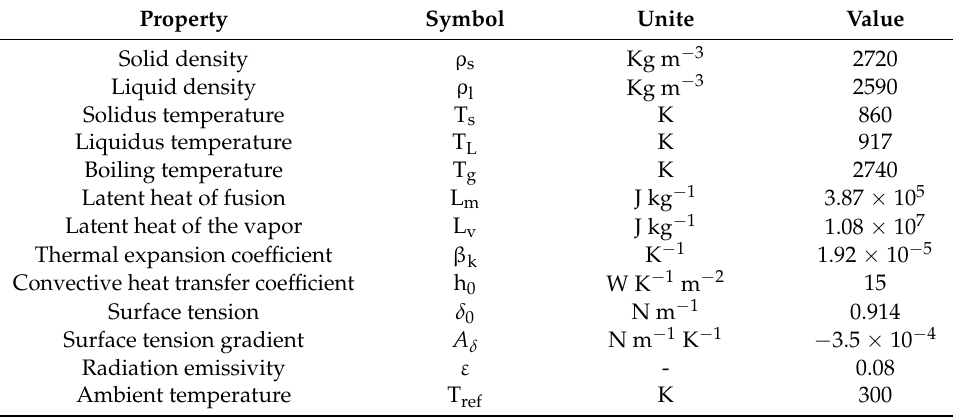
Latent heat of the vapor L v J kg − 1 1.08 × 10 7 Thermal expansion coefficient β